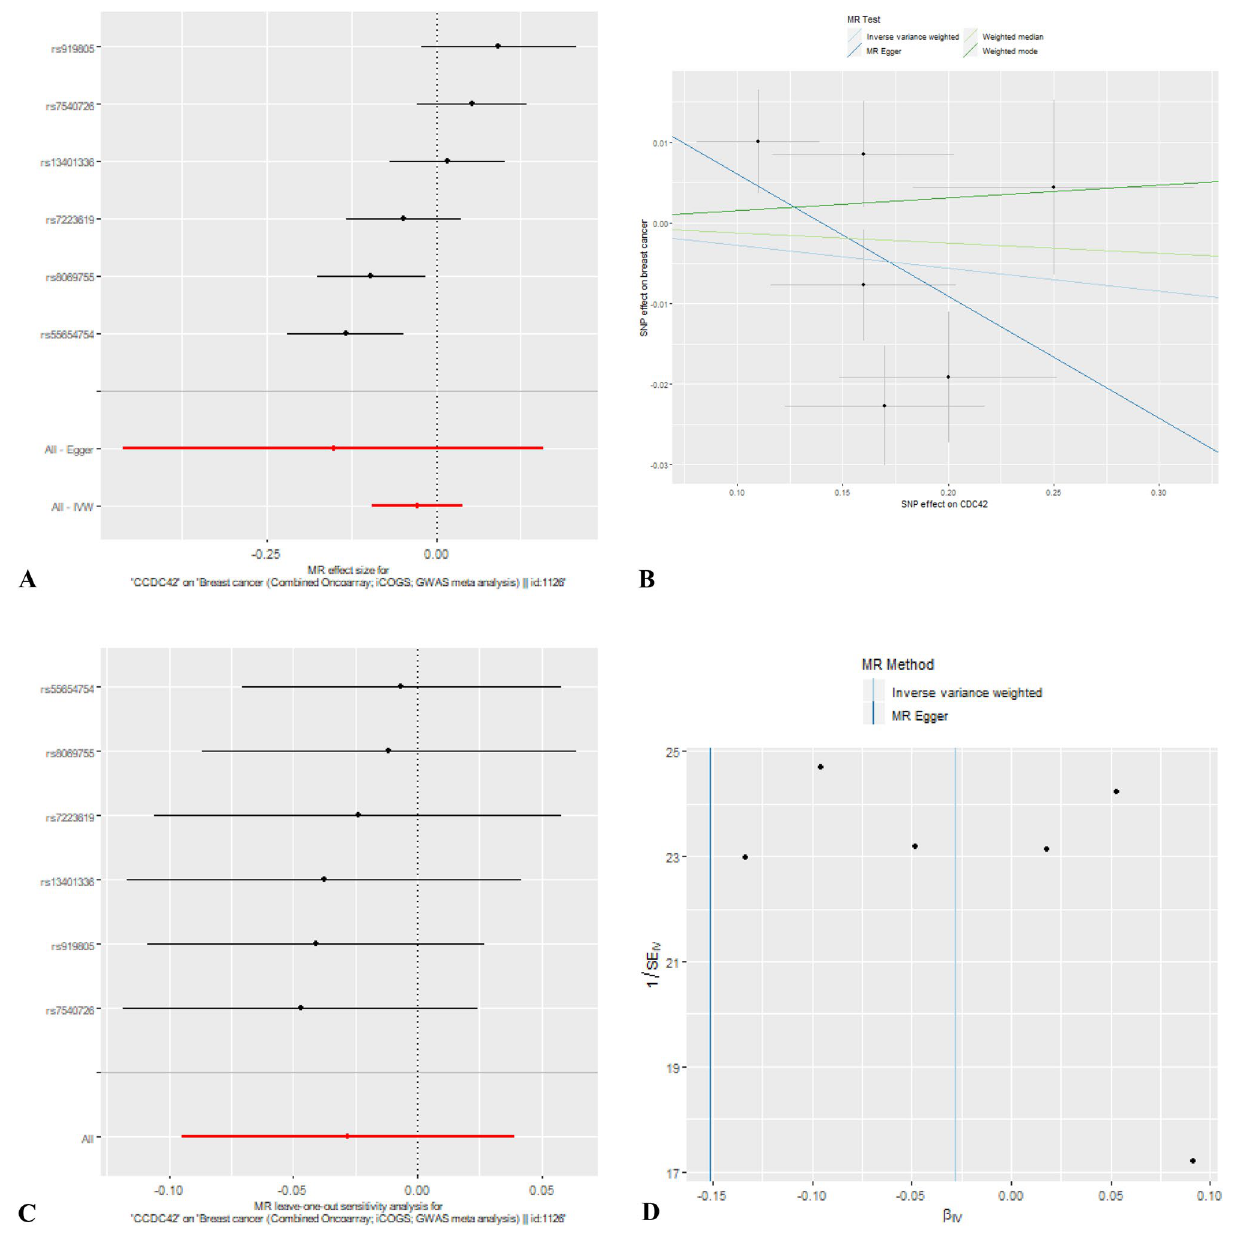
Figure 5. MR results for association between CDC42 and overall breast cancer risk using eQTLs from breast cancer. ( A ) forest plot of single SNP analysis; ( B ) comparison of results using different MR methods; ( C ) leave- one-out sensitivity analysis; ( D ) funnel plot of IVW and MR-Egger